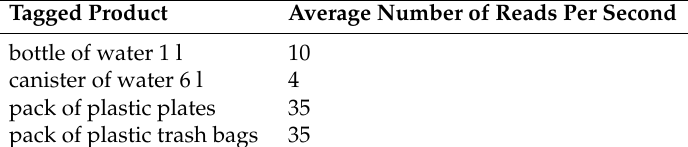
Table 6. Impinj reading results along the measurement trajectory of a Higgs 4 tag attached to different products.